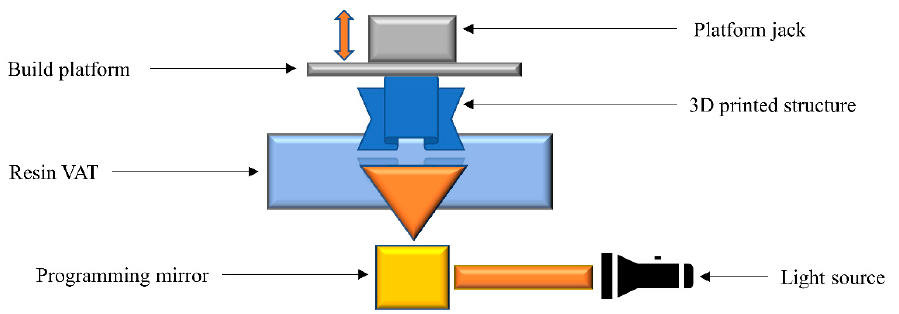
Figure 6. Schematic diagram of the digital light processing (DLP) process.